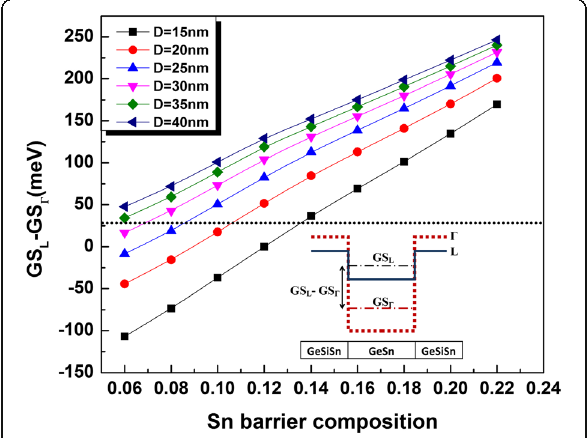
Fig. 3 Directness parameter (GS L -GS Γ ) variation as a function of the Ge room temperature. The inset represents a schematic definition of the directness